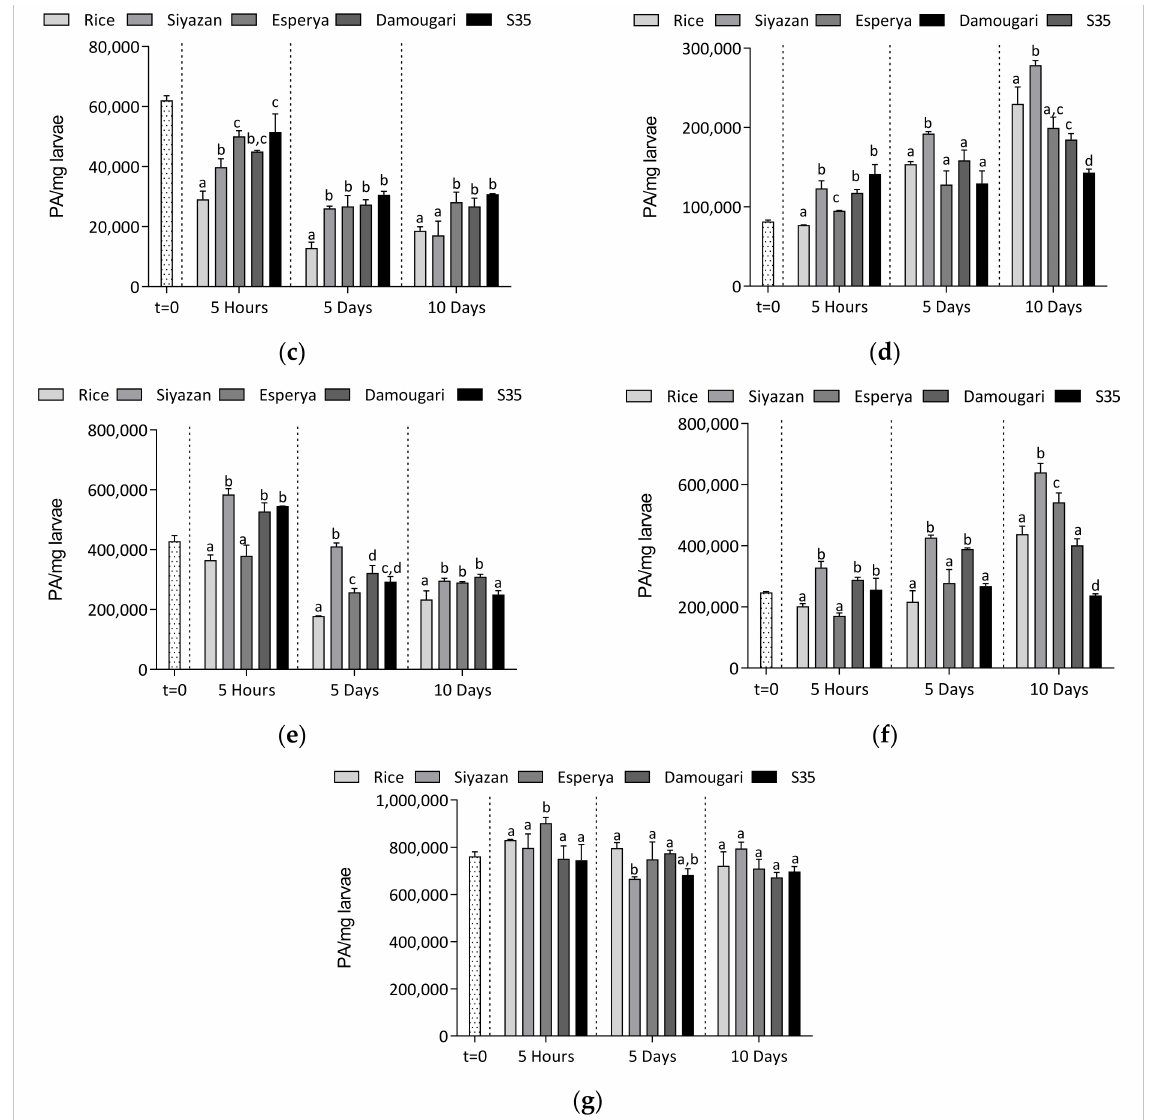
Figure 4. Changes in terms of relative content of ( a ) α -amylase, ( b ) CLIP domain-containing serine protease, ( c ) modular serine protease zymogen, ( d ) dipeptidylpeptidase I, ( e ) C1 family cathepsin B24, ( f ) chymotrypsin and ( g ) trypsin-like serine protease of larvae extracts as a function of intake type and feeding duration. Different letters indicate statistically significant differences at p = 0.05 (Tukey